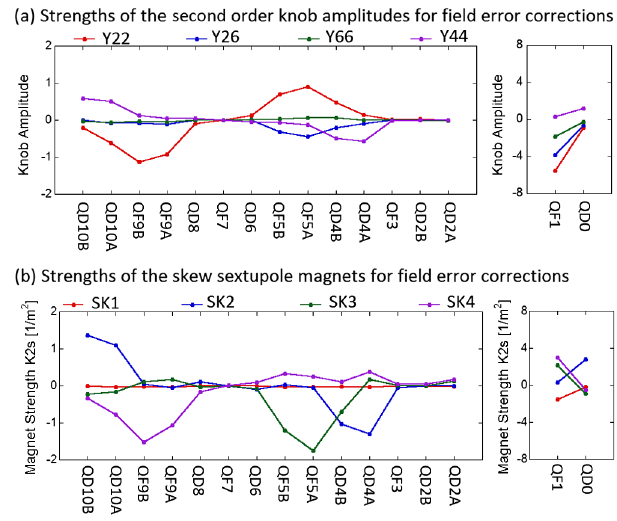
FIG. 16. Required strengths of the skew sextupole magnets to compensate for the case where each quadrupole magnet has a skew sextupole field K 2 S ¼ 1 m − 2 , in the 10 × 1 optics. (a) Strength of the tuning knobs and (b) strength of each correction